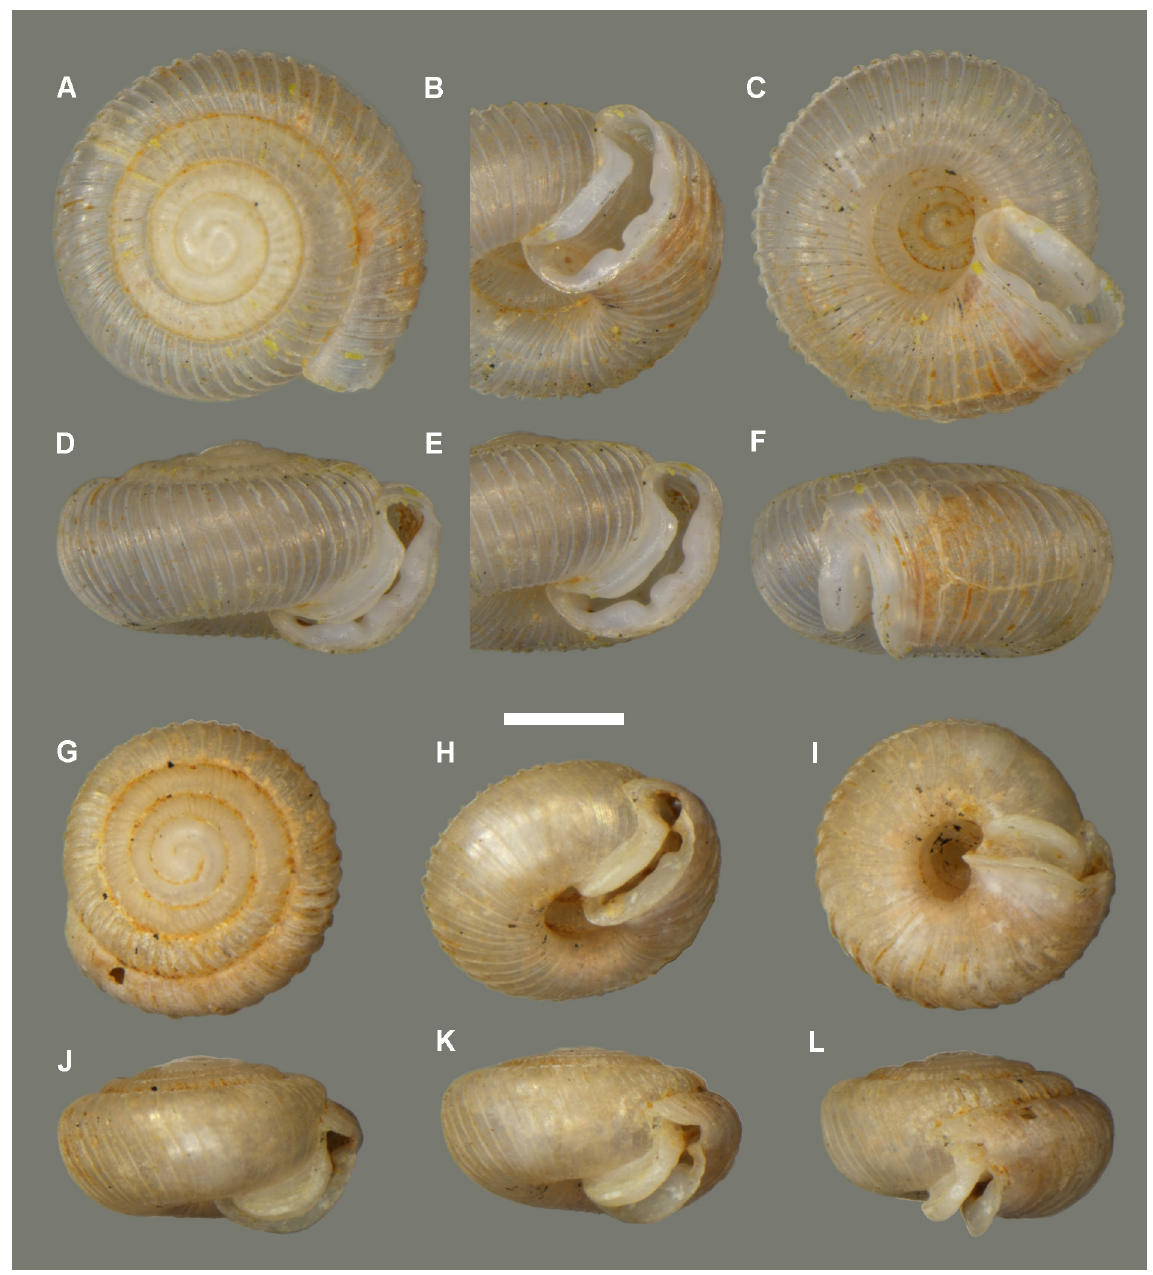
Fig. 1. Shells of species of Virpazaria Gittenberger, 1969. A–F . Virpazaria (Virpazaria) adrianae Gittenberger, 1969, holotype (NHMW-E 57441). G–L . Virpazaria (Virpazaria) backhuysi Gittenberger, 1969, holotype (NHMW-E 48856). Scale bar = 1